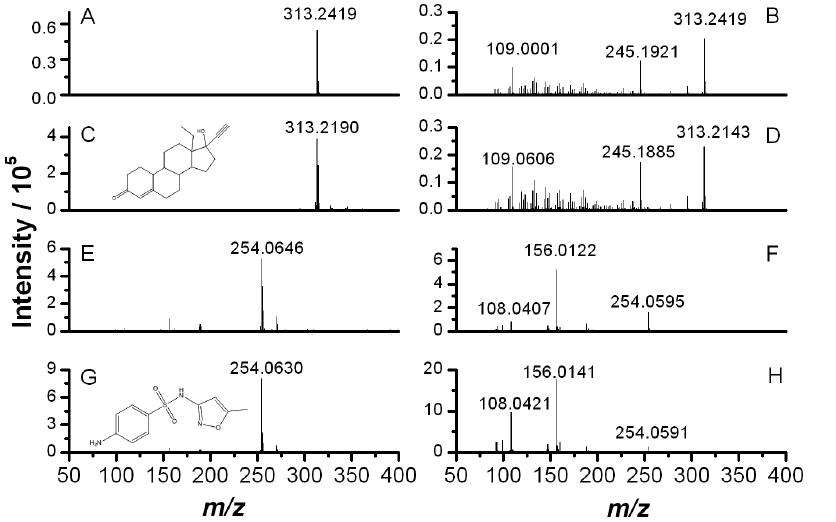
Figure 4. DART MS and MS/MS analysis using a collision energy of 20 eV. (A): Mass spectrum of a contraceptive tablet containing levonorgestrel. (B): MS/MS spectrum for the precursor ion with m/z 313.2419 shown in A. (C): Mass spectrum of levonorgestrel standard. (D): MS/MS spectrum for the precursor ion with m/z 313.2190 shown in C. (E): Mass spectrum of sample 2a. (F): MS/MS spectrum for the precursor ion with m/z 254.0646 shown in E. (G): Mass spectrum of sulfamethoxazole standard. (H): MS/MS spectrum for the precursor ion with m/z 254.0630 shown in G.